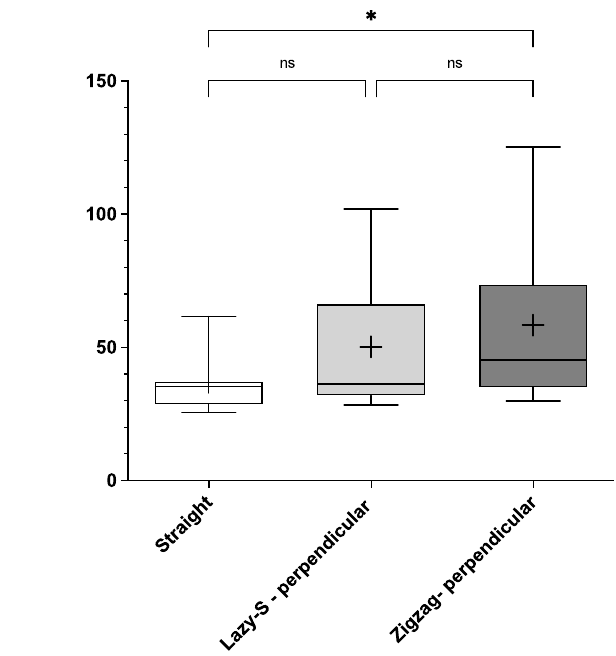
Figure 3. First suture failure load (first failure load) for three main incision patterns. Conventional straight, Lazy-S and Zigzag incisions (both with perpendicular (90°) placement of sutures) were tested for their biomechanical stability. The mean is indicated by a cross. The bottom and top of the box are the 25th and 75th percentile. Error bars (whiskers) indicate the 10th and 90th percentile. * p < 0.05; ns , not significant. For each group 17 incision-patterns were tested.